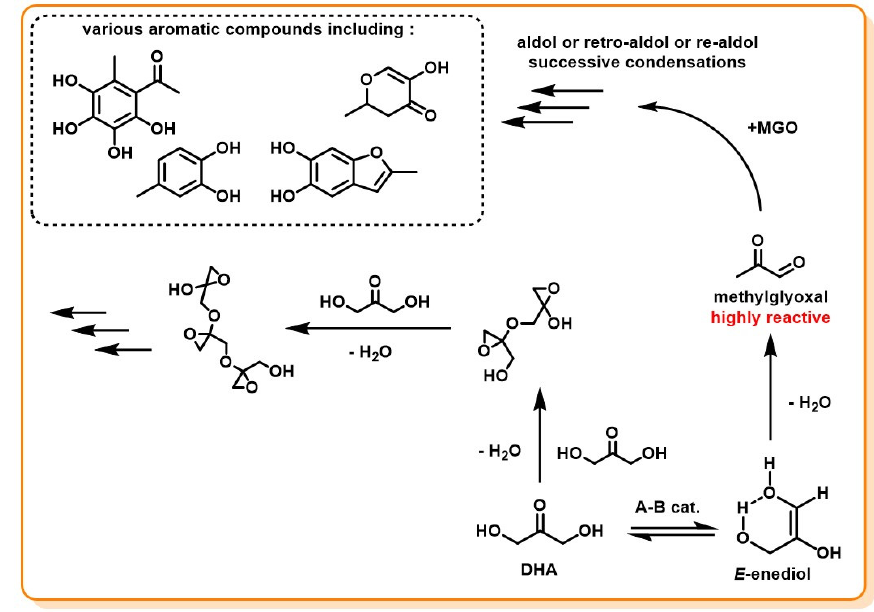
Figure 11. Condensation reaction paths from DHA and the enediol intermediate.